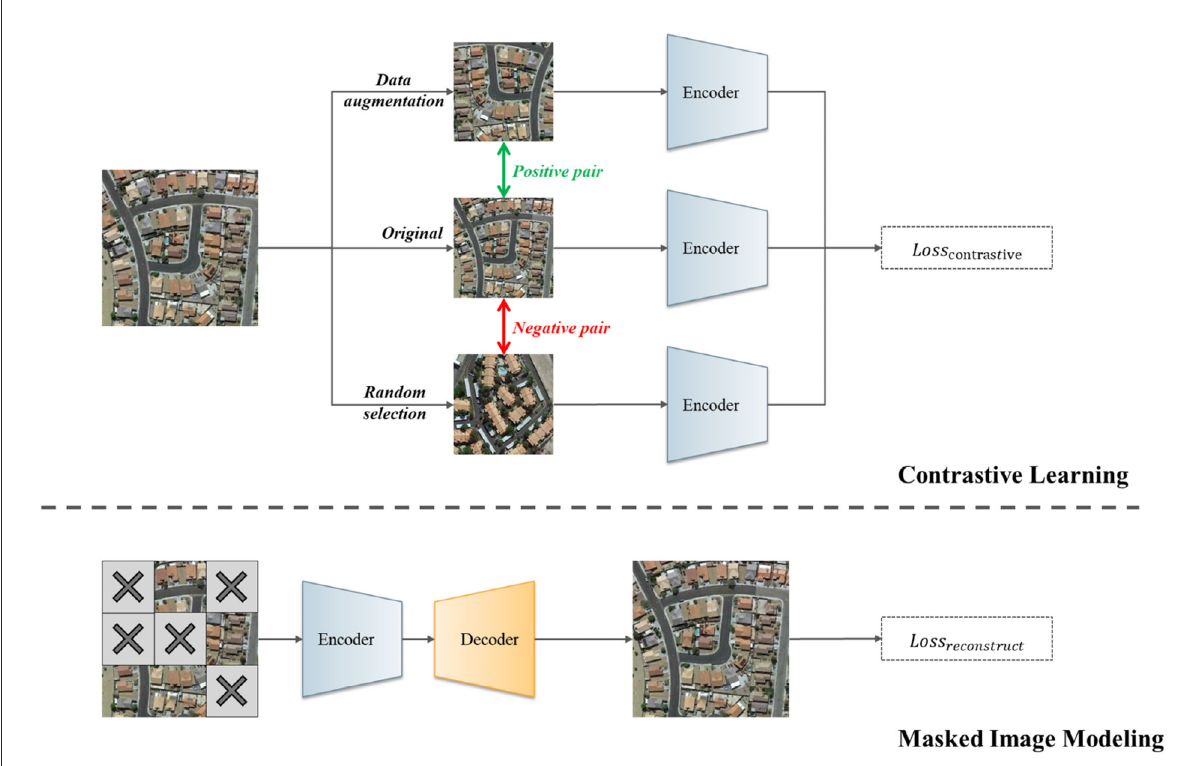
FIGURE1 A brief introduction of the contrastive learning methods and masked image modeling